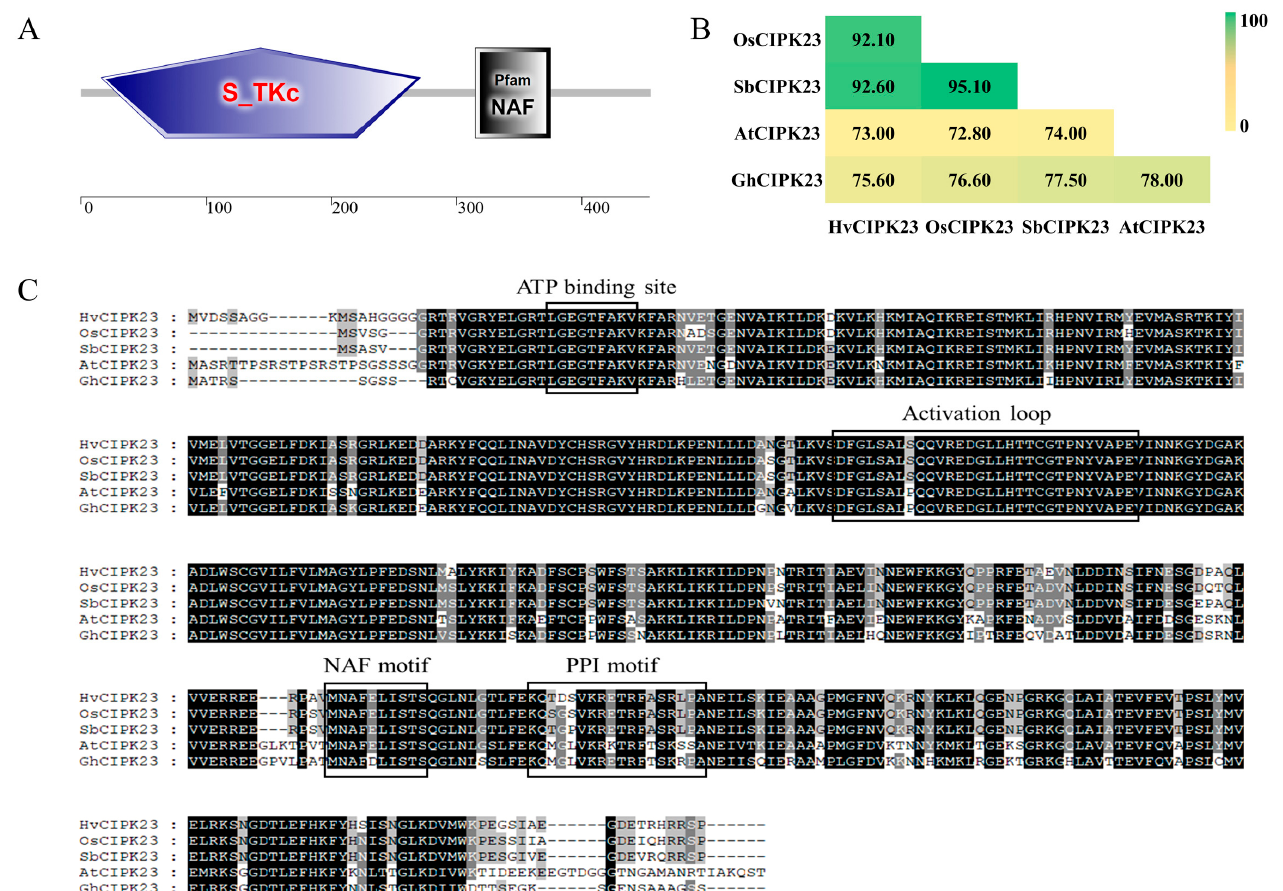
Figure 3. Domain and sequence identity analysis of GhCIPK23 protein in upland cotton. ( A ) Protein domain prediction of GhCIPK23. ( B ) Protein sequence identity analysis of GhCIPK23 and CIPK23 protein of other species. ( C ) Amino acid sequence alignment of GhCIPK23 and CIPK23 protein of other species.